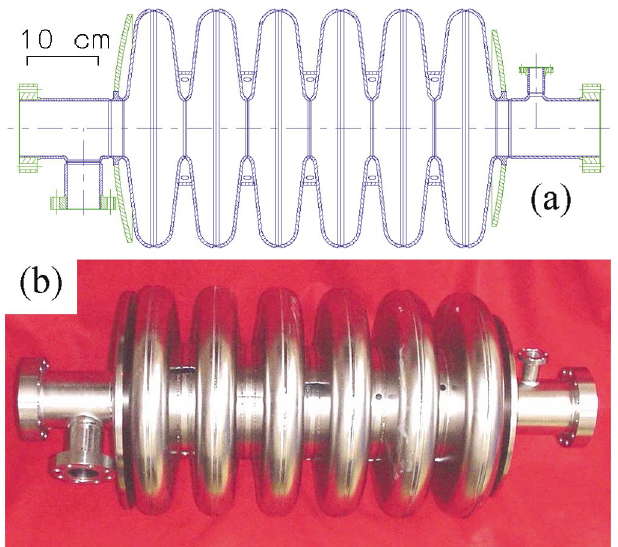
(cid:7) g FIG. 6. (Color) Bead pulls for the second 6-cell niobium cavity. The phase shift (proportional to the square of the electric field) as a function of bead position z was measured with a network analyzer.